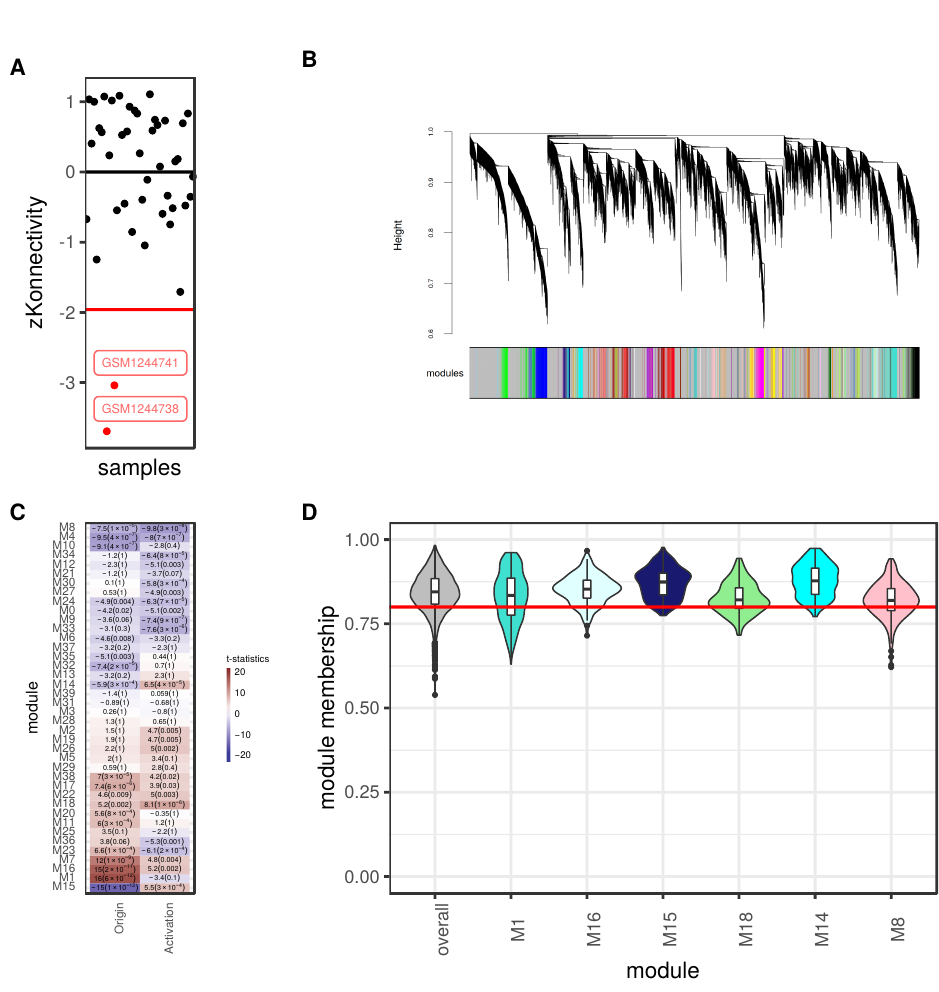
Figure 5. Identification of modules that are associated with either origin (tumour vs. non-tumour endothelial cells) or angiogenic activation. ( A ) Outlier identification based on the z-normalized intersample connectivity (zK). The red line denotes a zK of 1.96. Potential outliers are labelled red. ( B ) Dendrogram showing detected modules. Each branch of the dendrogram represents a gene assigned to one of the modules. Grey areas represent genes not assigned to any module. ( C ) Heatmap showing the association between a module and either cell origin or angiogenic activation. The top number represents the t-statistic, the number in brackets the associated adjusted p -value. A positive t- statistics indicates up-, a negative t-statistics represents downregulation in the TEC (indicated by “cell origin”), and ENG + cells (indicated by “activation”). ( D ) Module membership for the entire network (overall), for the M1, M16, M15, M18, M14, and M8 module. The red line denotes a membership of